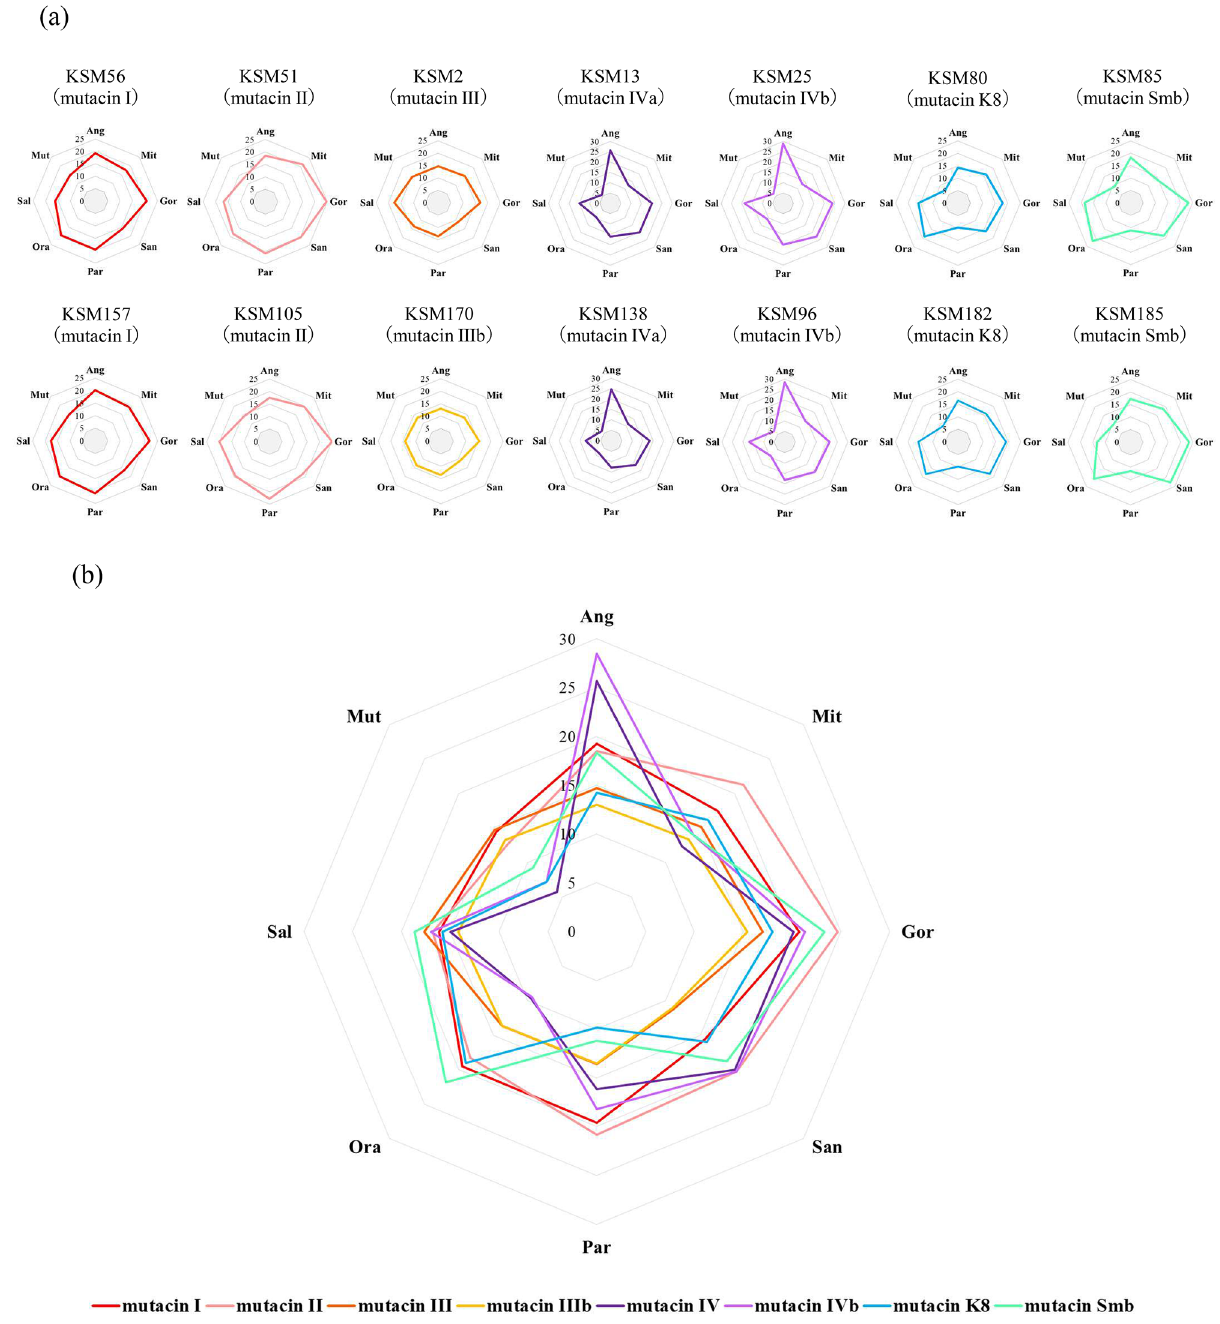
Figure 3. Antibacterial activity of each bacteriocin gene single-positive strain against 8 oral streptococcal species. To evaluate the antibacterial activity of bacteriocins, a direct assay was performed with the method described in the Materials and methods section. ( a ) Two single-positive strains for each bacteriocin except mutacin III and mutacin IIIb were selected. ( b ) Merged antibacterial activity of each single positive strain (KSM2, 13, 25, 56, 51, 80, 85, 170). Three independent experiments were performed, and the average diameter was calculated. The number in each panel represents the diameter of the inhibition zone (mm). Ang: S. anginosus , Mit: S. mitis , Gor: S. gordonii , San: S. sanguinis , Par: S. parasanguinis , Ora: S. oralis , Sal: S. salivarius , Mut: S.